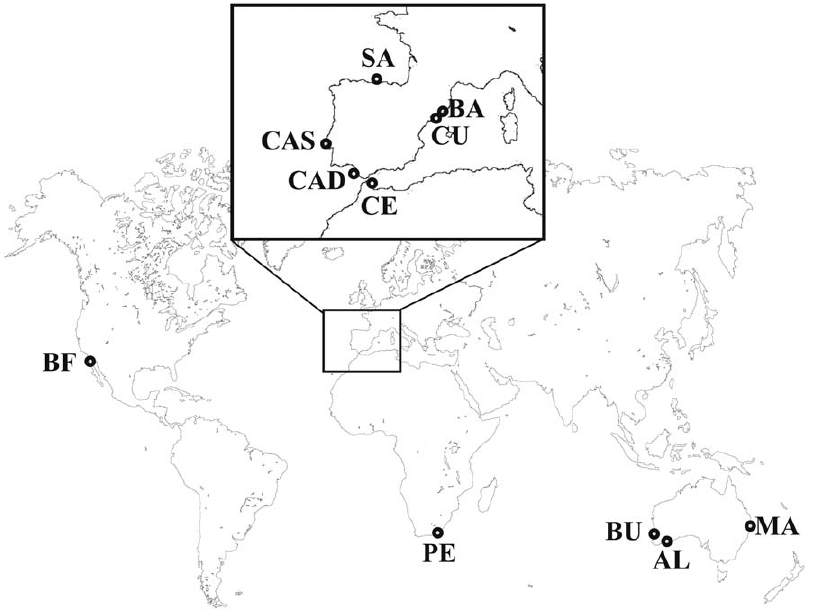
Figure 1. Map of the sampled sites of Microcosmussquamiger . The Atlanto-Mediterranean region has been enlarged. Collection sites are abbreviated as in Table 1.